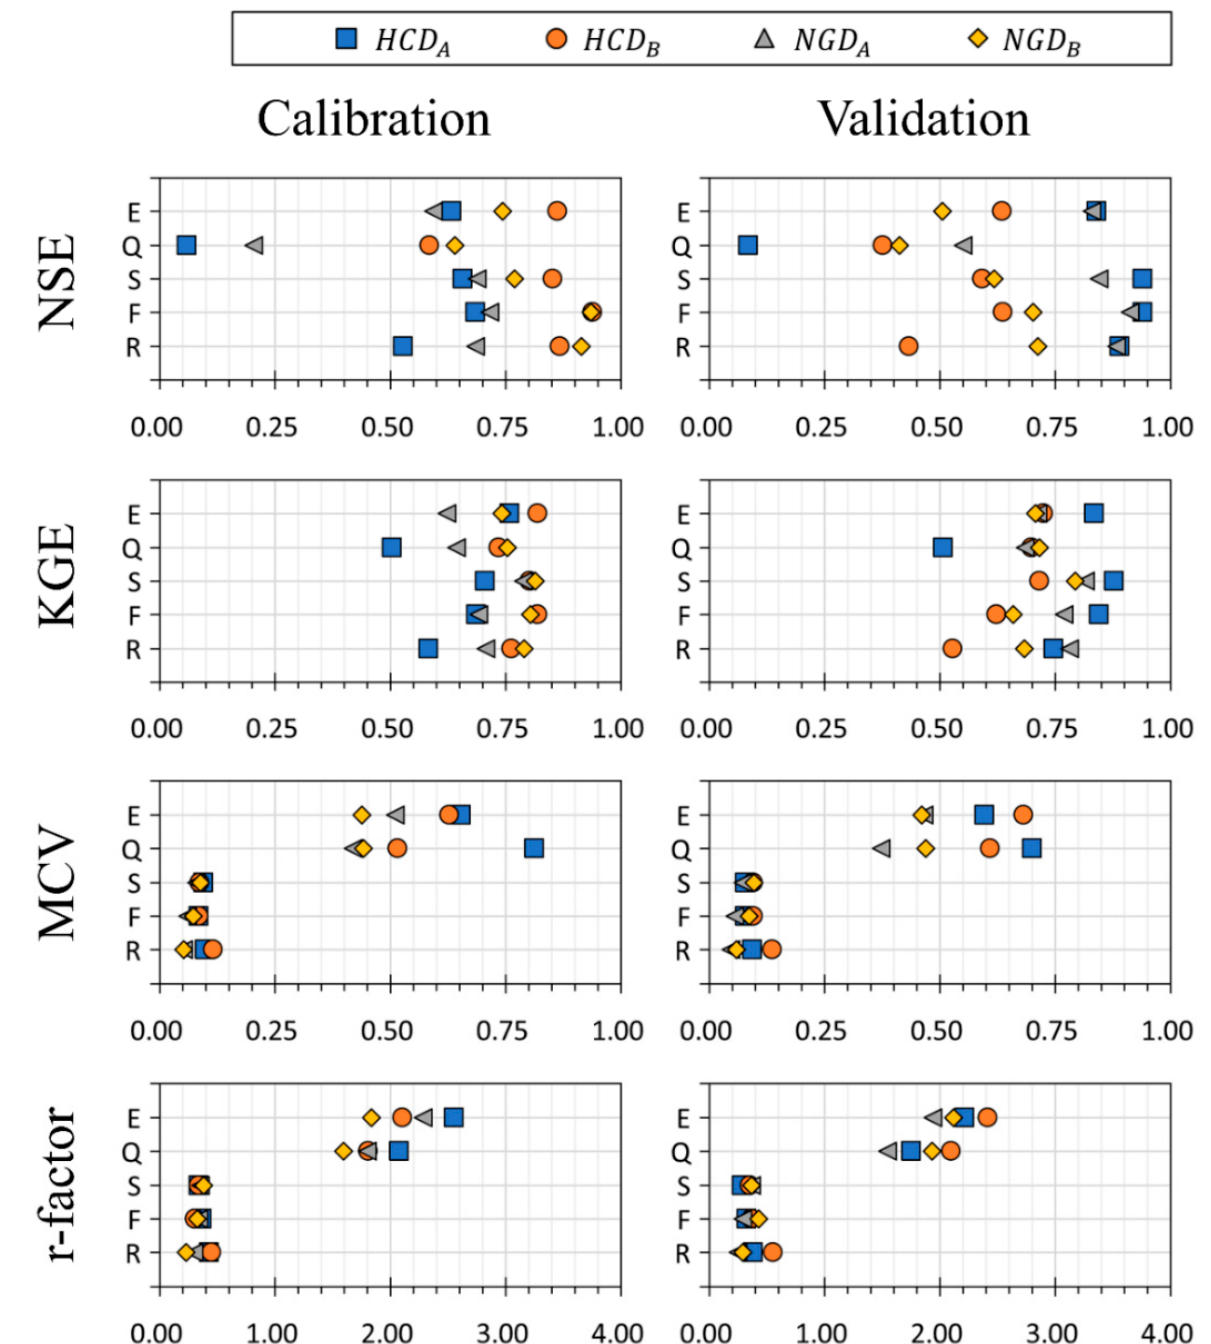
Figure 5. Performance metrics (NSE and KGE) and uncertainty metrics (MCV and r-factor) between observed and simulated monthly stream flow for calibration period and validation period.